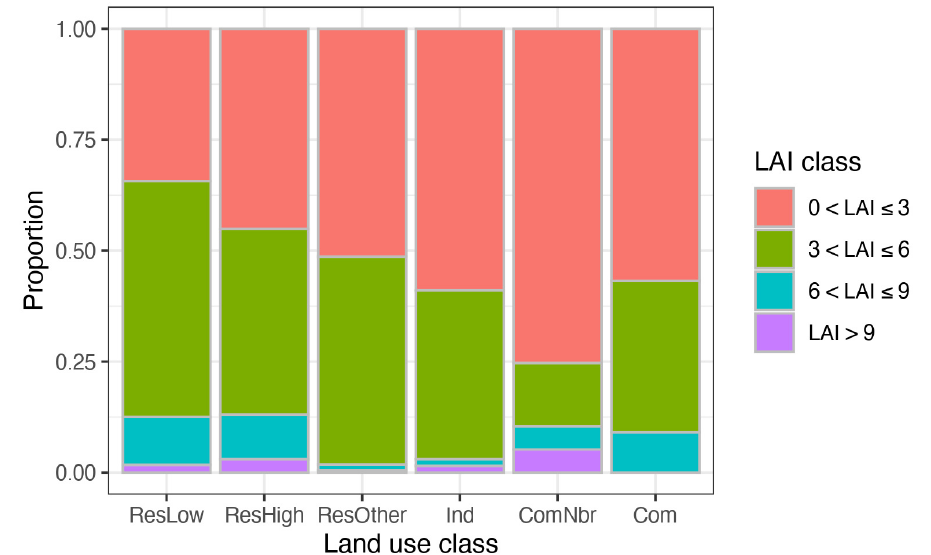
Figure 3. LAI (leave area index) distribution across land use classes.